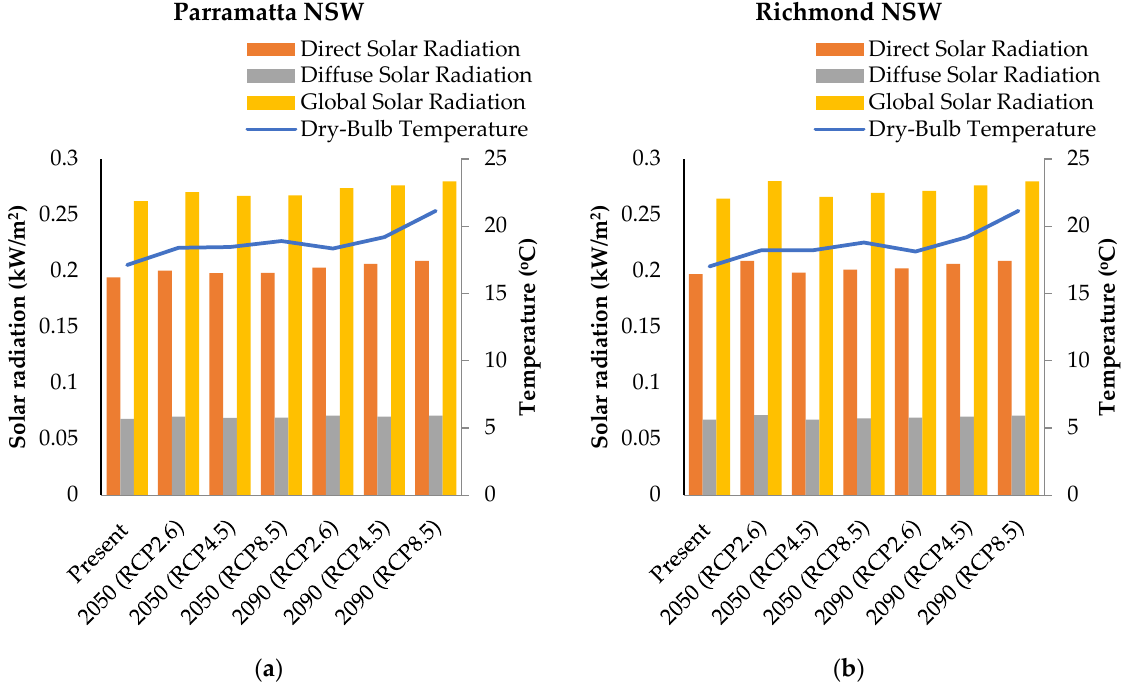
Figure 4. Annual present and projected temperature and radiation: ( a ) Parramatta; ( b ) Richmond. To generate future weather files, the morphing method developed by Belcher et al. [47] along with different global climate models were used [45]. The morphing method is well-established and the most commonly used method to predict future climate condi- tions [34]. The typical meteorological year (TMY) data sets derived from historical weather data from 1990 to 2015 were used as the baseline weather files in the morphing method. Please refer to Ren et al. [45] for more details.